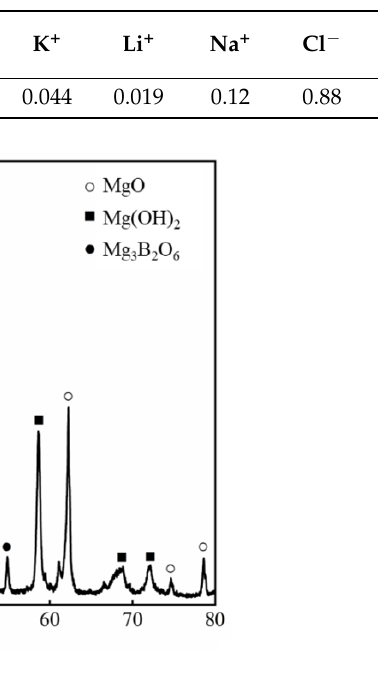
Table 1. Chemical composition of the magnesium residue.